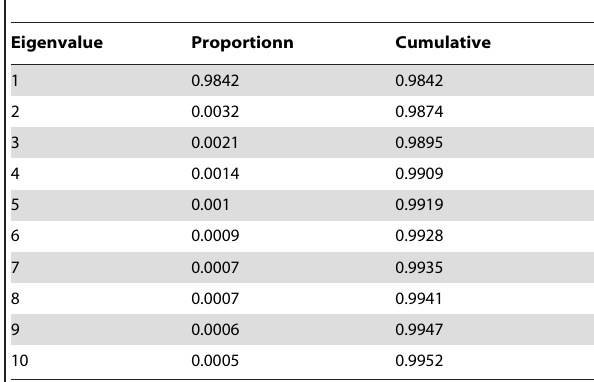
Table 3. Proportional and cumulative variance expressed